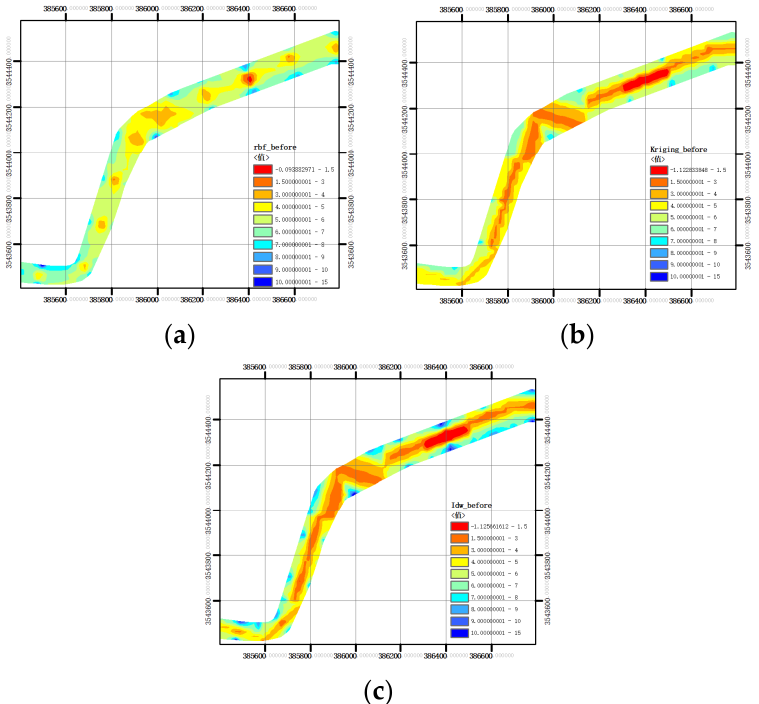
Figure 9. Interpolation results directly using ( a ) RBF, ( b ) Kriging, and ( c ) IDW without preliminary encryption under CGCS2000 coordinate system.